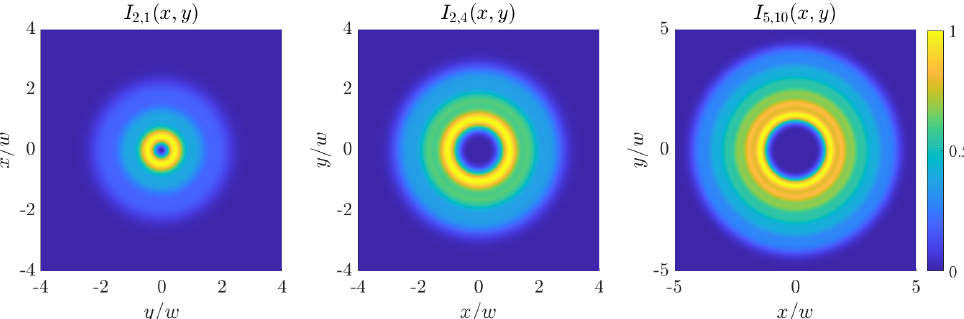
Figure 2. Maps of the intensity I Nm (normalized to the maximum) across the source plane for three different pairs ( N , m ) (as indicated in the figure